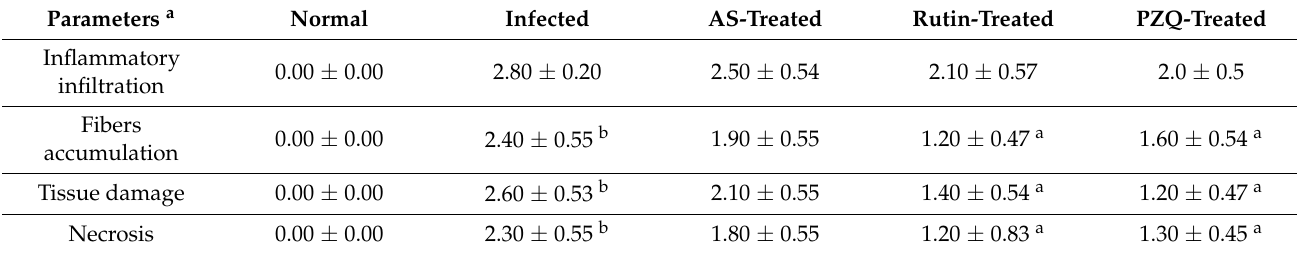
Table 4. Histopathological analysis in mice after different treatment.